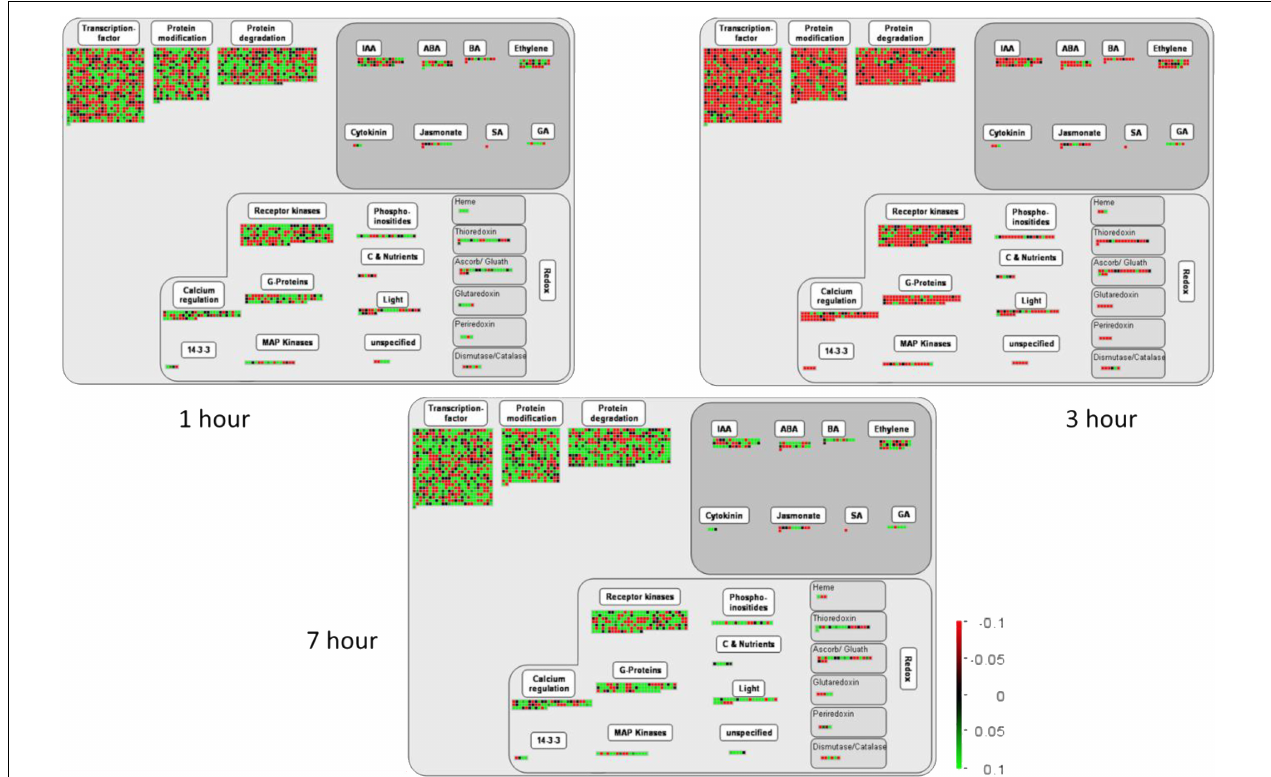
FIGURE 6 | This figure exhibits the MapMan expression analysis of various DETs involved in several molecular and cellular functions at 1, 3, and 7 h of salt treatment in pearl millet. Here, the green color in the heatmap shows the upregulation of TFs and DETs, and the red color shows the downregulation when the TFs and DETs were compared among various combinations as mentioned on the top of each column. Moreover, “S” indicates salt-treated groups, “CK” indicates the control group, and “h” is used for hours, i.e., 1 hour (1 h), 3 hours (3 h), and 7 hours (7